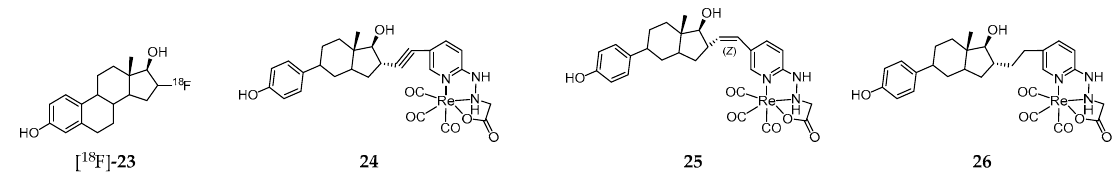
Figure 4. G protein–coupled estrogen receptor (GPER) ligands based on the 17 β -estradiol scaffold.